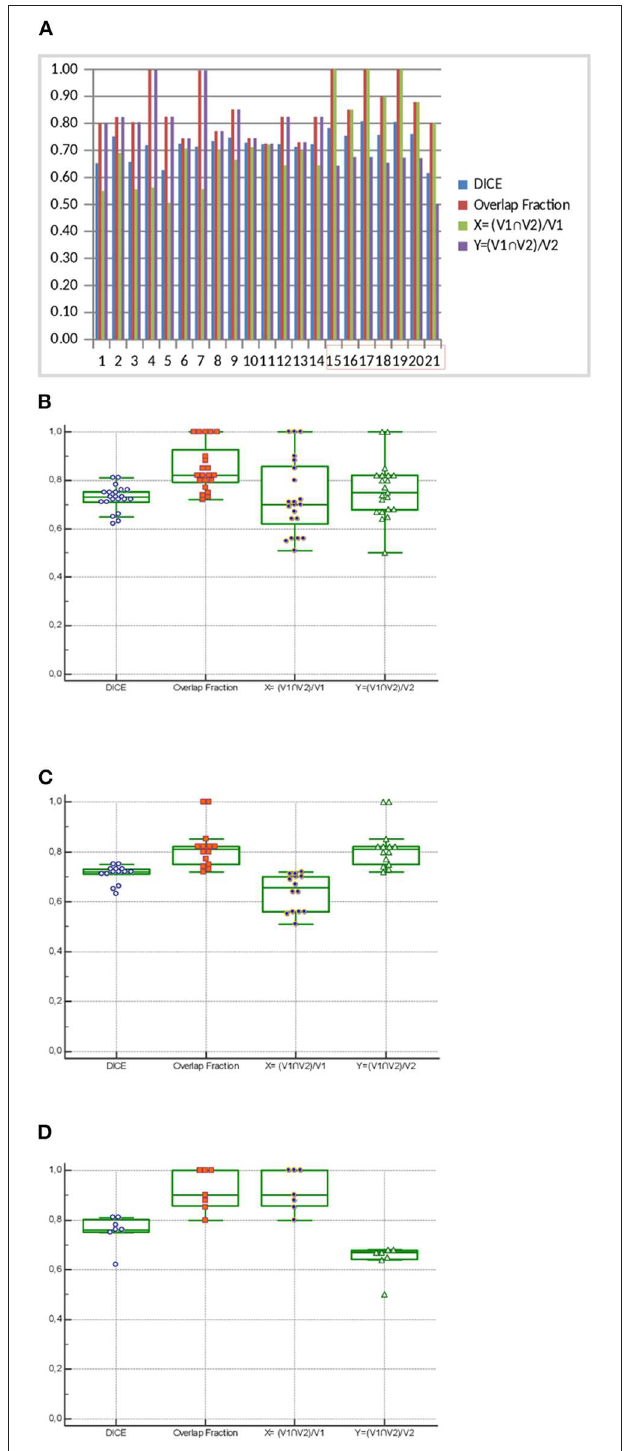
FIGURE 3 | Histogram ( A , patients with V2 > V1 are in the red box) and box plot corresponding ( B : n = 21 including 7 patients with V2 < V1, C : n = 14 V2 < V1, and D : n = 7 V2 > V1) to the overlap analysis: Dice coefficient, Overlap fraction, and intersection of V1 and V2 volumes divided by either V1 (X = (V1nV2)/V1) or V2 (Y =